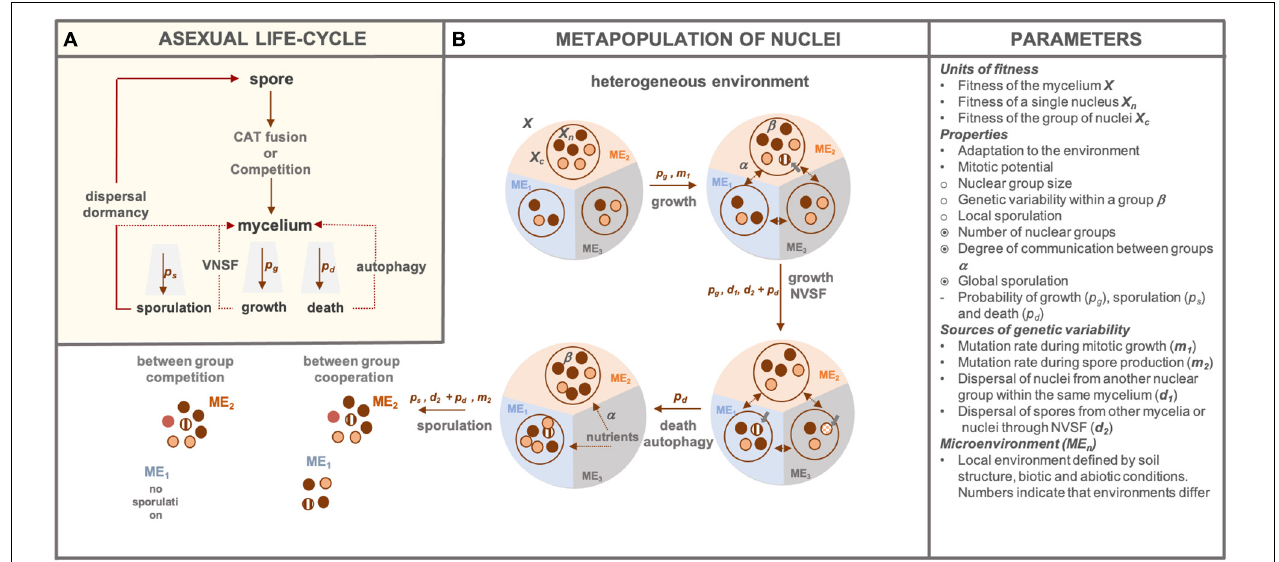
FIGURE 1 | Schematic representation of the asexual fungal life-cycle and nuclear metapopulation. (A) We show an asexual spore which can, following germination, undergo CAT fusion or competition if other spores are present. Germlings develop into a mycelium that can die, grow and/or sporulate with probabilities p d , p g and p s , respectively. Dashed lines indicate alternative events that can take place. That is, if death occurs only in parts of the mycelium, autophagy can take place, providing energy reserves to subsidise growth or sporulation of other mycelial parts. Similarly, a growing mycelium can fuse with other genetically distinct mycelia through VNSF. In a sporulation event, spores may fuse with an existing mycelial network or pass through the cycle again independently. (B) We show a mycelium as a metapopulation of nuclei in a heterogenous environment (ME 1 , 2 , 3 ), with fitness of the mycelium, nuclear group and an individual nucleus denoted as X , X c , and X n , respectively. If the environmental conditions allow, the mycelium will grow through mitotic divisions of nuclei, which introduces mutant nuclei (denoted with grey bolded arrow) at a species-specific rate m 1 . Within-group genotype diversity, denoted as β , can be the same or different between groups depending on within-mycelium nuclear mixing, denoted by α , the connectivity parameter. Nuclear subpopulations can change quantitatively and/or qualitatively by immigration from other groups ( d 1 ) or by introduction of distinct genetic material through successful (depending on the p d ) VNSF ( d 2 ). Similarly, older or resource-deprived parts of mycelium may undergo cellular death and autophagy, which can subsidise other mycelial parts with energy for growth or sporulation. Sporulation can occur across the mycelium if there is between-group cooperation. If there is competition between the groups, some groups may not contribute or contribute less to the spore pool. Genetic diversity may be introduced in the spore pool through successful immigration (depending on the p d ) of spores from another mycelium ( d 2 ) or mutations and mitotic rearrangements during spore production ( m 2 ). The last panel on the right (“Parameters”) provides explanations for denotations used in the scheme and a short list of properties at every level with • , ◦ , •(cid:13) representing nuclear, group and mycelium level, respectively. Similarly, “-” represents traits that can be attributed to either of the levels. Different colours of nuclei or spores indicate genetic